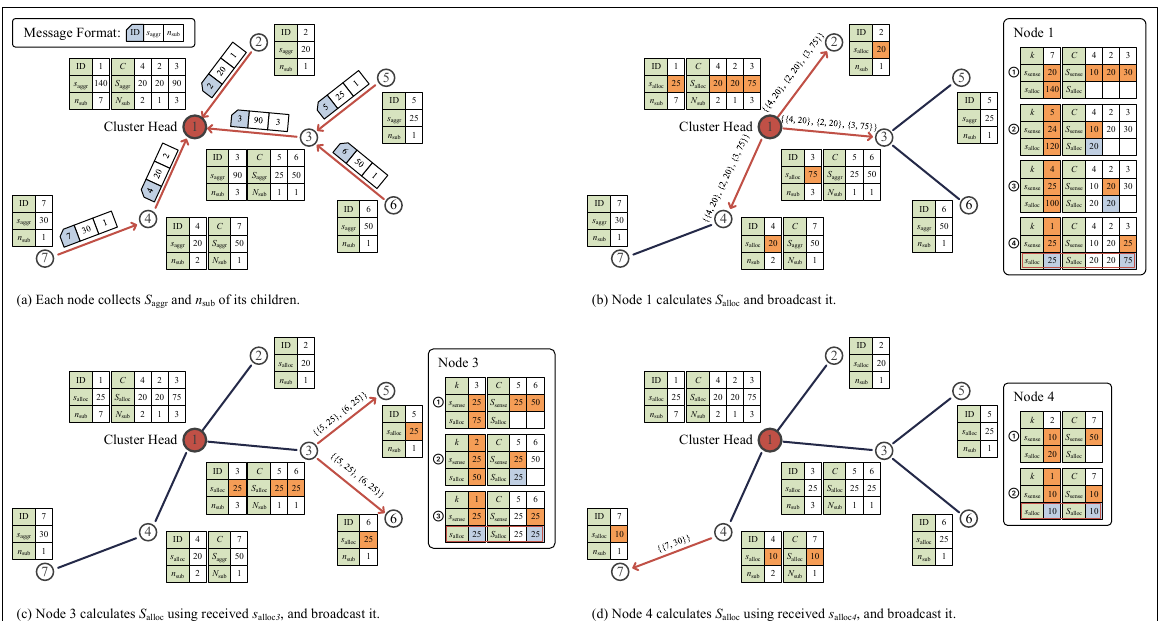
Figure 3. Data allocation